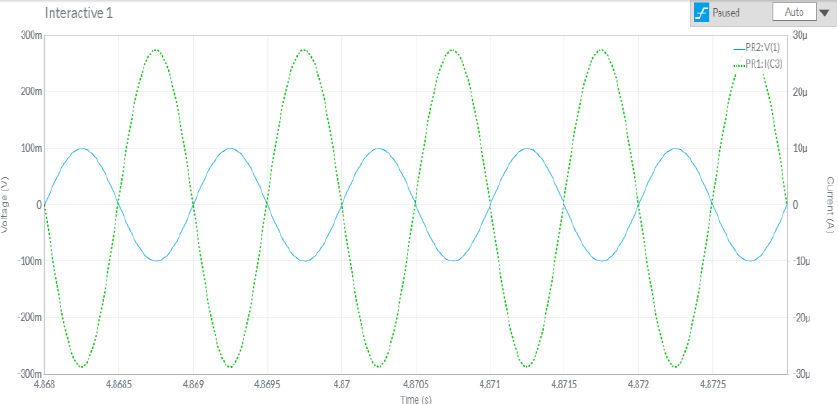
Figure 8. Output Voltage Signal for TIP31C Transistor.